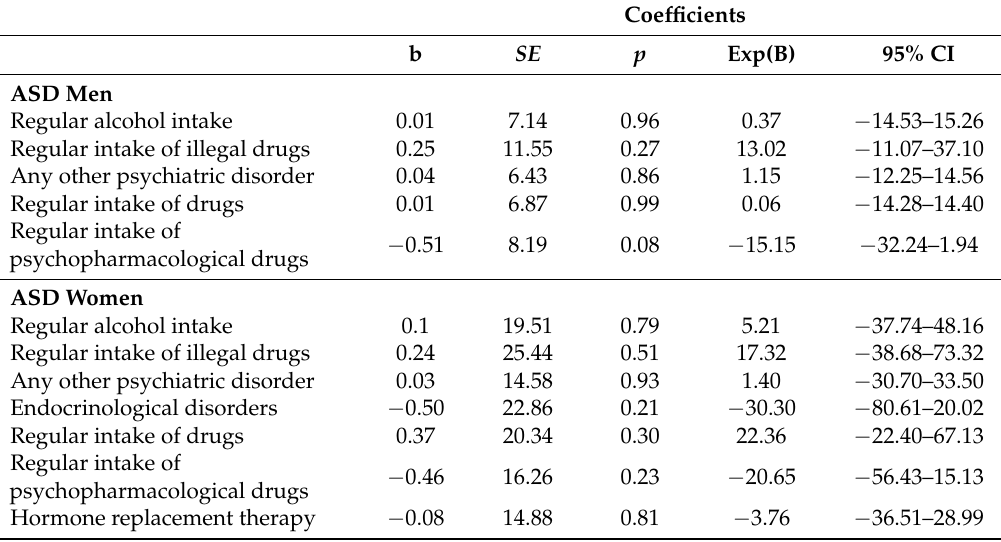
Table 3. Linear logistic regression addressing the relationship between clinical factors and sexual dysfunctions in individuals with Autism Spectrum Disorder